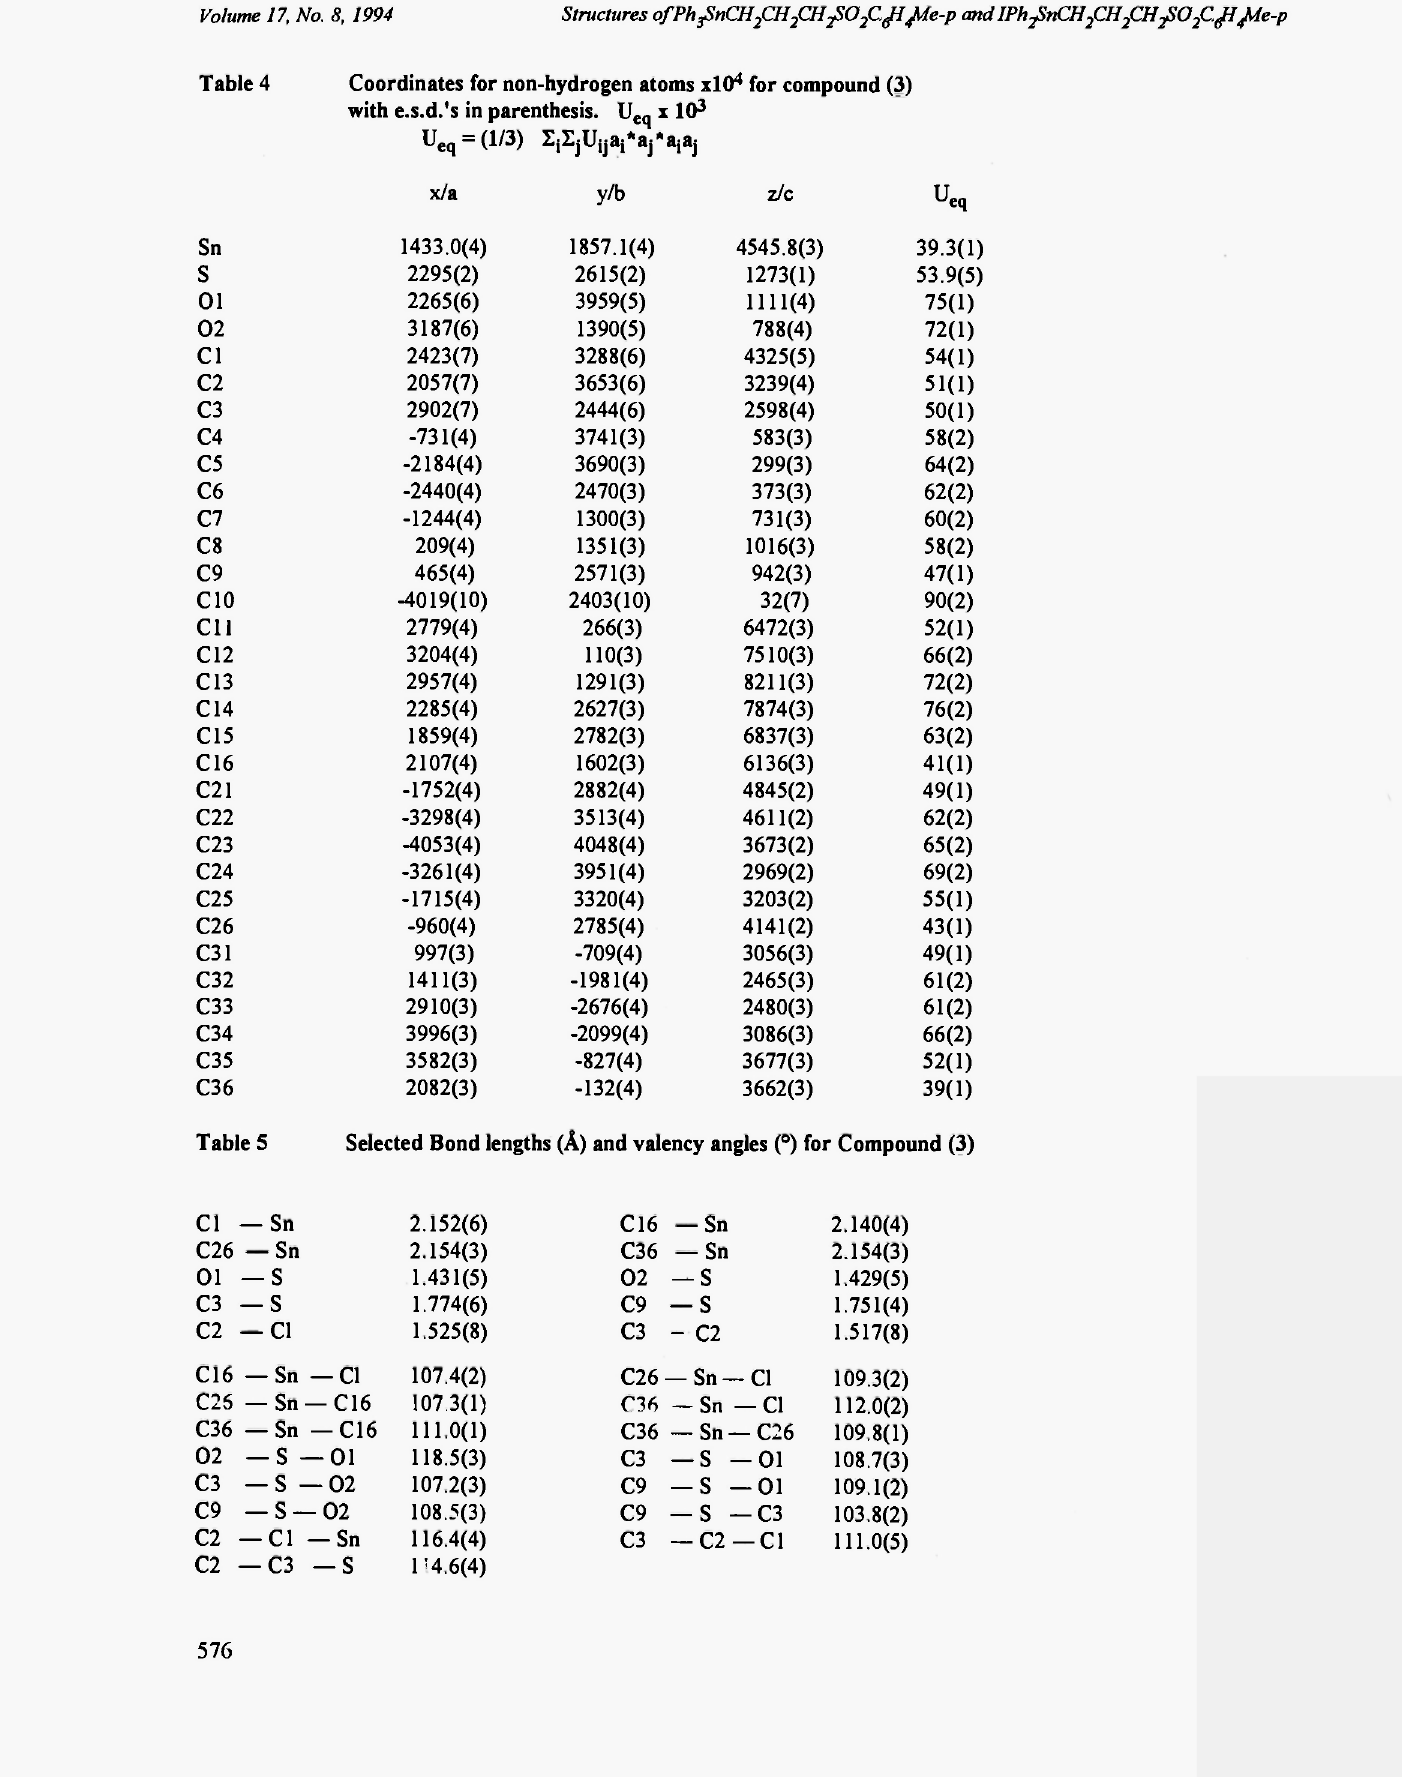
Coordinates for non-hydrogen atoms xlO 4 for compound (3)